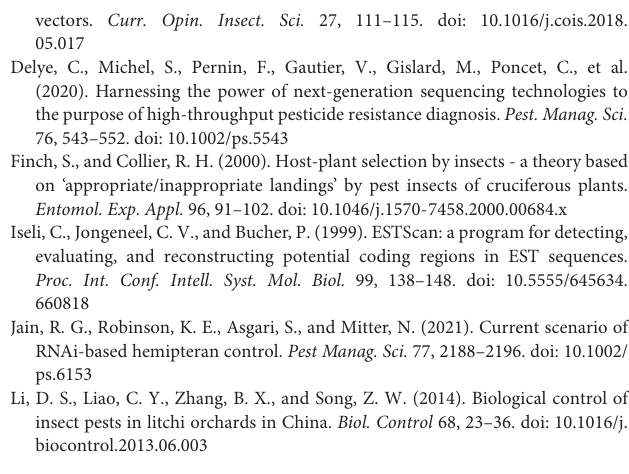
Supplementary Figure 1 | Distribution map of unigene transcript length and predicted CDS length. (A) The abscissa represents the transcript length interval, and the ordinate represents the number of corresponding transcripts. (B) The abscissa represents the CDS length interval, and the ordinate represents the number of the corresponding CDS. Supplementary Figure 2 | The number of genes of each transcription factor families. Supplementary Figure 3 | (A) Heat map of correlation coefficient between samples. Both X and Y axes represent each sample. The color represents the correlation coefficient (the darker the color, the higher the correlation, and the lighter the color, the lower the correlation). (B) Principal component PCA analysis between samples. (C) Express volume box plot. The X-axis is the sample name, and the Y-axis is log10 (FPKM+1). The box plot of each region corresponds to five statistics (from top to bottom, the upper limit, upper quartile, median, and lower quartile). Number of digits, lower limit, the upper and lower limits do not consider outliers). (D) WGCNA gene module detection. In the figure, a branch of the clustering tree represents a gene, and genes with highly similar expressions are grouped together and belong to the same module (indicated by the same color). The gene correlation between each module is displayed in yellow and red progressive colors. The darker the color (red), the higher the correlation between the two